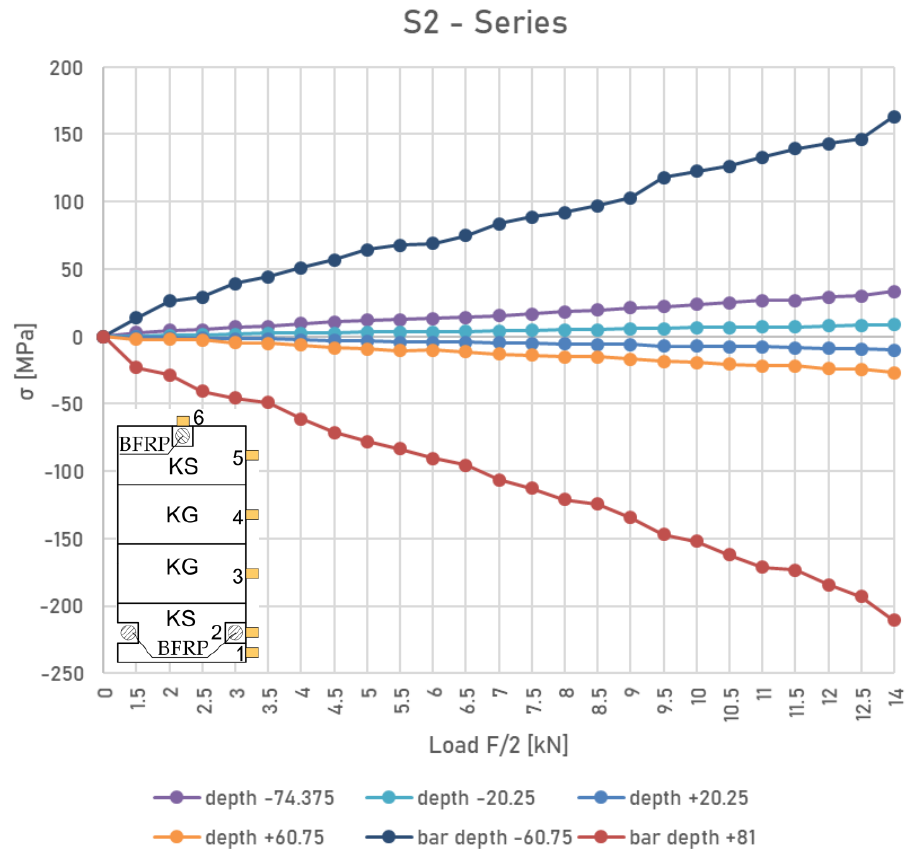
Figure 7. Typical stress distribution profile in the tension and compression zones for S2 series of reinforced beams.